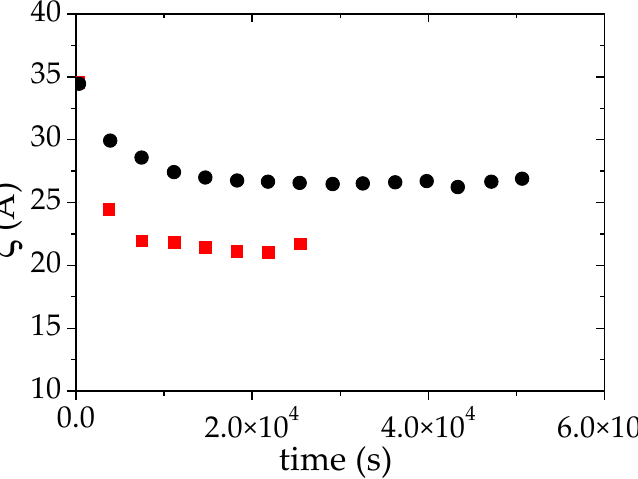
Figure 5. Evolution of the apparent correlation length ξ during the LCST phase separation of PMAA solution in D 2 O ( Φ PMAA,0 = 0.065), induced by a temperature jump from 25 °C up to: +1 °C ( ● ) and +10 °C ( ■ ) above the cloud point. ξ was deduced from the fit of the SANS data to Equation (3).